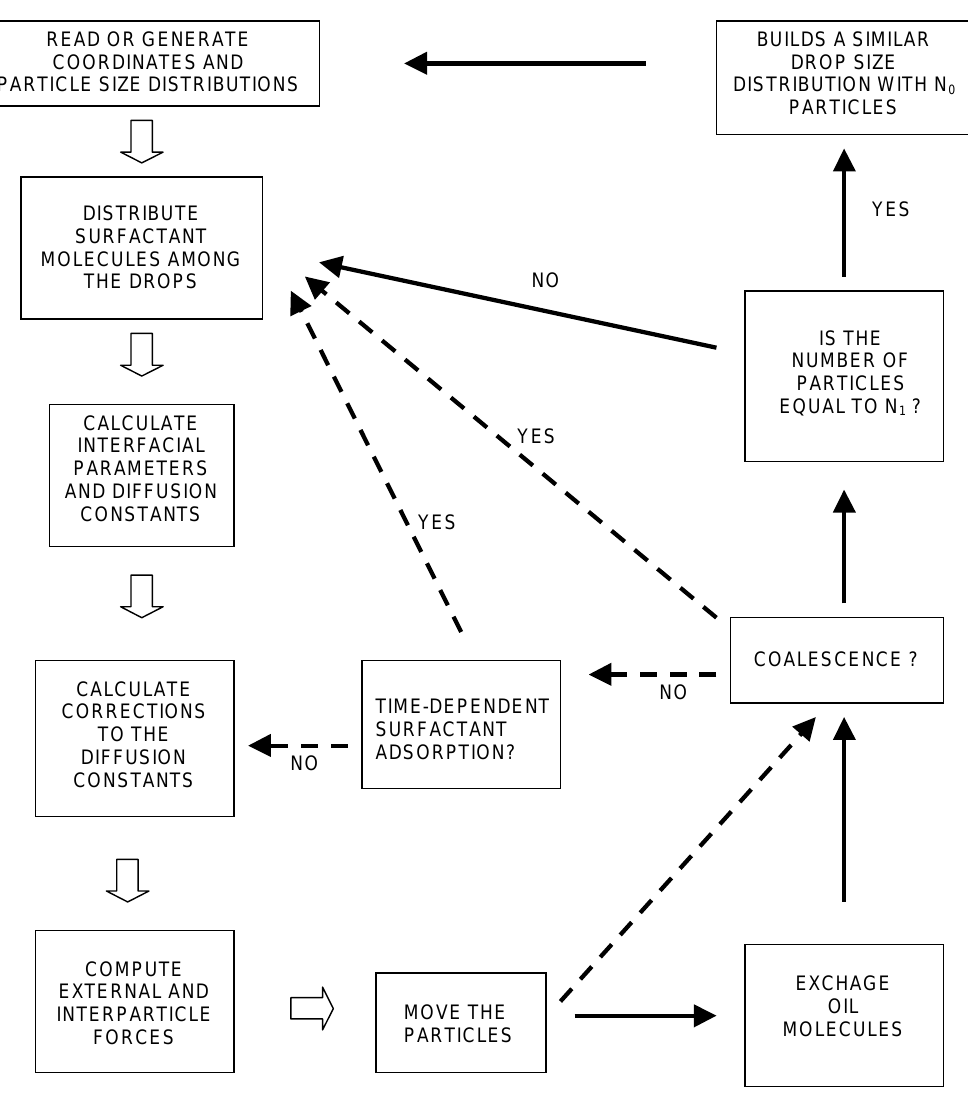
Figure 2. Flowchart of Emulsion Stability